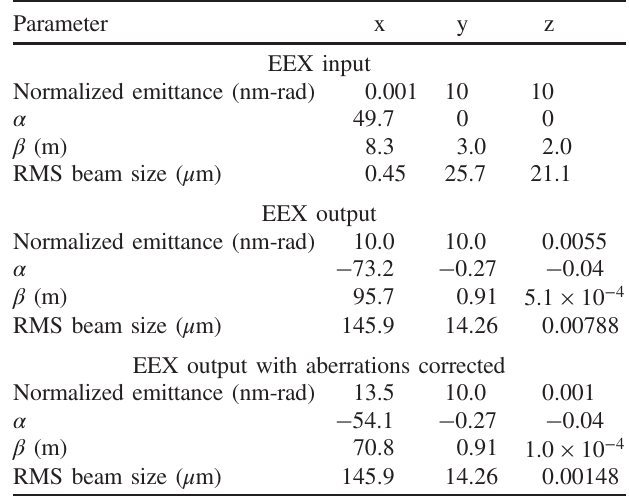
TABLE VI. Emittance and Twiss parameters.